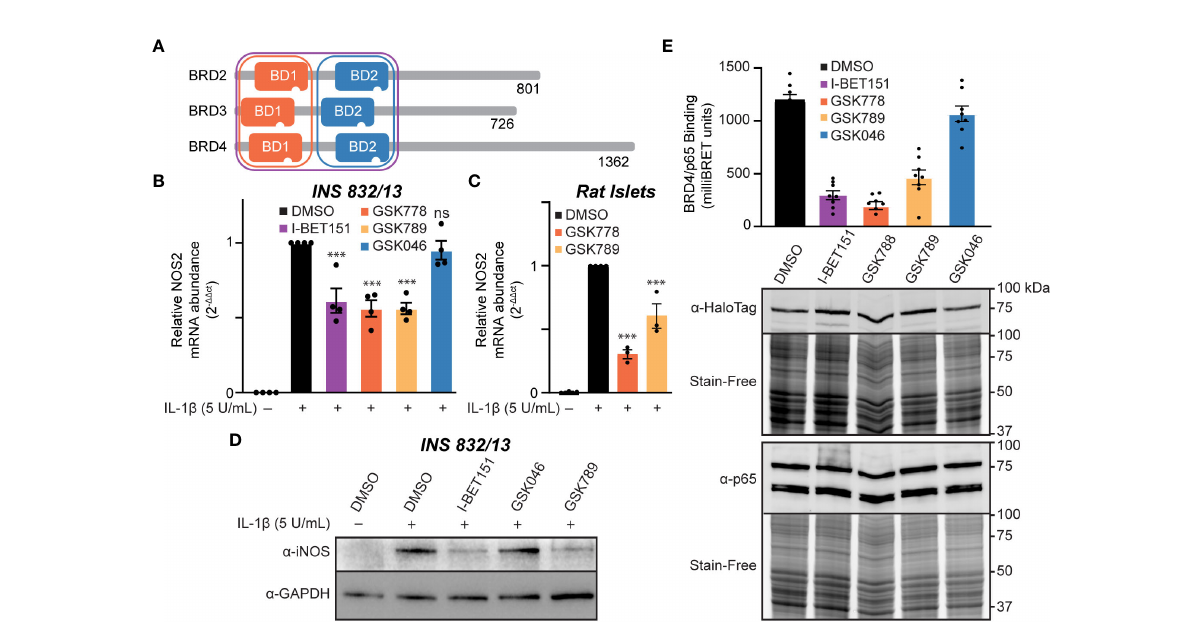
FIGURE 5 Inhibition of the fi rst BET bromodomains is suf fi cient to reduce IL-1 b -driven NOS2 transcription. (A) Schematic representation of BET bromodomain proteins highlighting the bromodomains inhibited by each inhibitor class. Modi fi ed from Gilan et al. (56). (B) RT-qPCR analysis of NOS2 transcript levels in INS 832/13 cells treated for 1 hour with 1 m M indicated BET bromodomain inhibitor followed by IL-1 b (5 U/mL) for 3 hours. (C) RT-qPCR analysis of NOS2 transcript levels in rat islets treated for 3 hours with 10 m M indicated BET bromodomain inhibitor followed by IL-1 b (5 U/mL) for 3 hours. (D) Immunoblot using an antibody directed against iNOS protein in INS 832/13 cells pre-treated with 1 m M indicated BET bromodomain inhibitor followed by IL-1 b (5 U/mL) for 20 hours. (E) NanoBRET assays completed in INS 832/13 cells transfected with Halo-tagged BRD4 tandem bromodomains and nanoluciferase-tagged p65 exposed to 2 m M indicated BET bromodomain inhibitor followed by BRET intensity reading. Immunoblot for iNOS is representative of two independent biological replicates. For RT-qPCR, error bars represent the standard error of the mean (SEM) from 3-4 independent biological replicates, and signi fi cance was determined by ANOVA followed by Dunnett ’ s multiple comparisons tests, *< 0.05, **< 0.01, ***< 0.005, and ns >